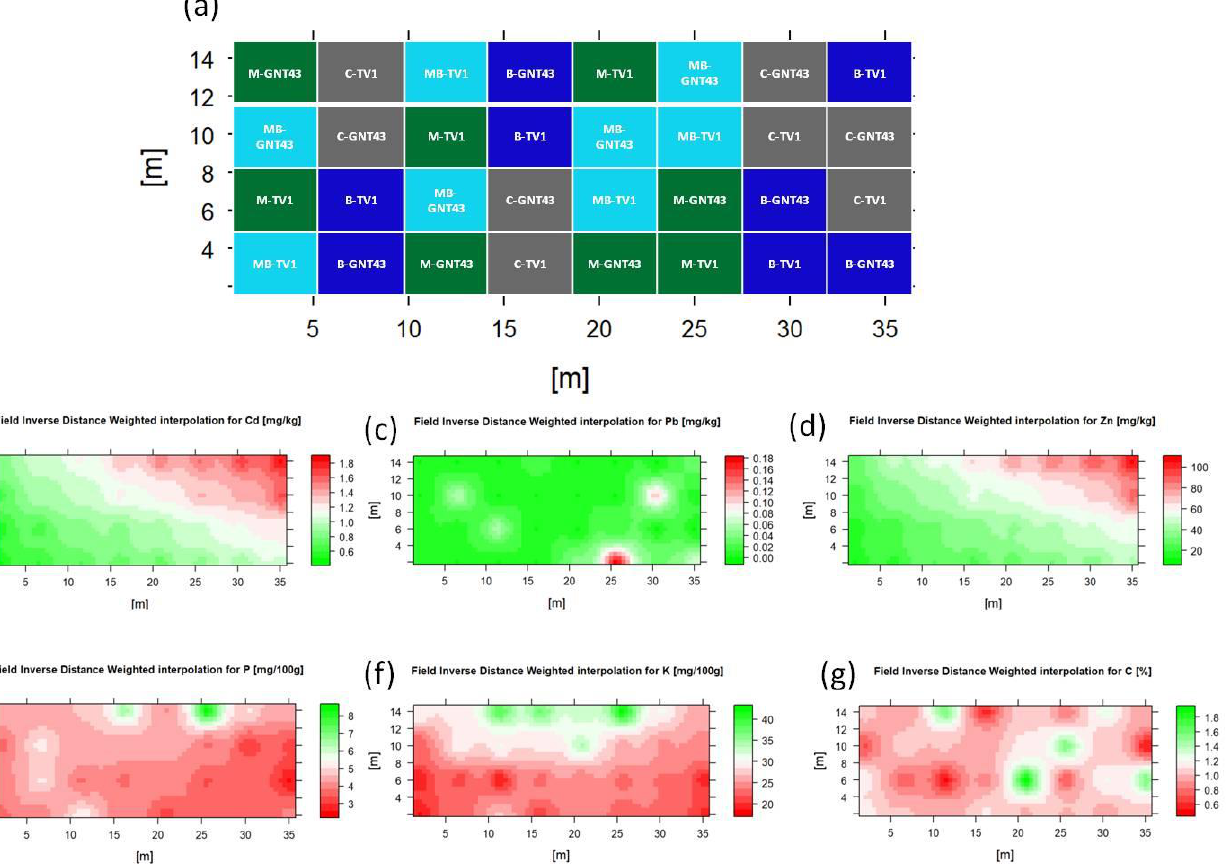
Figure 1. Trial design ( a ) and visualization of the bio-availability of selected elements in the soil ( b – g ). Color graduation for Pb, Cd, and Zn is from green to red, while for other visualised parameters, from red to green . Table 1. The soil physicochemical characteristics on experimental plots.